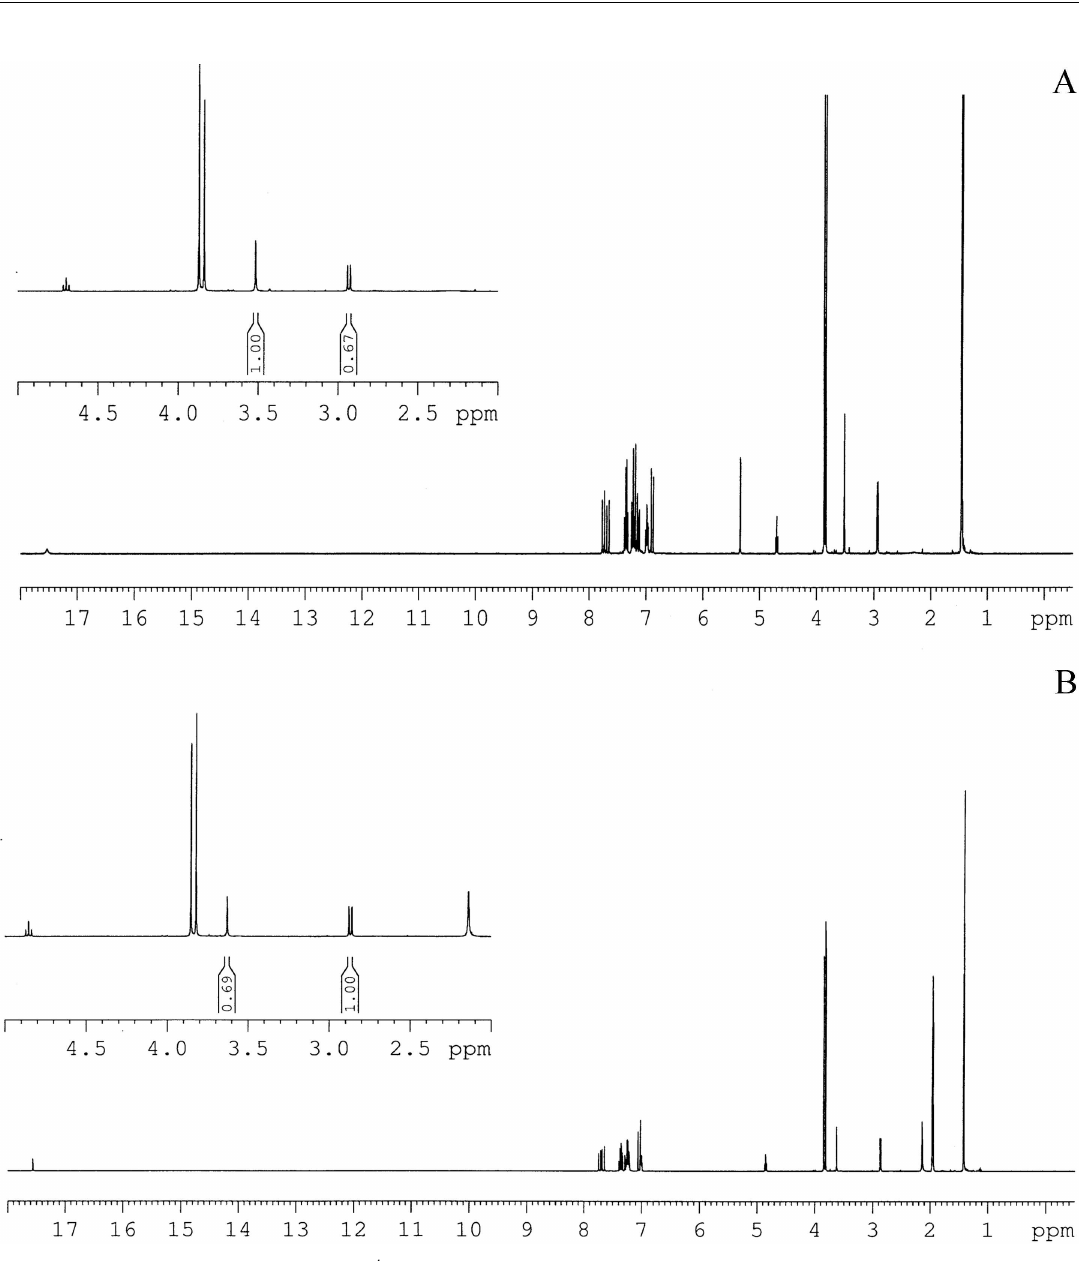
Fig 4. Exemplary NMR spectraof K2T23. 1 H NMR spectra of K2T23 at room temperature in d 2 -Dichloromethane (upper panel)and d 3 -Acetonitrile(lower panel). In the insets the zoom of the region between2 ppm and 5 ppm, where the peaks integratedto derive the fraction of compoundin the diketo conformers, is presented.